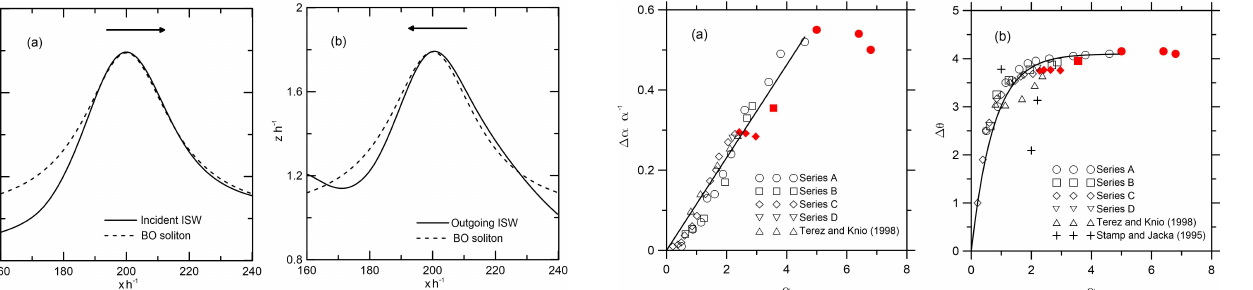
Figure 4. Relative runup excess (cid:49)α (a) and phase shift (cid:49)θ (b) of the interacting symmetric ISWs versus the normalized amplitude of the wave α . The filled symbols correspond to the cases with KH instability. The fits, done by using a straight line in panel (a) and an exponential function in panel (b) , are